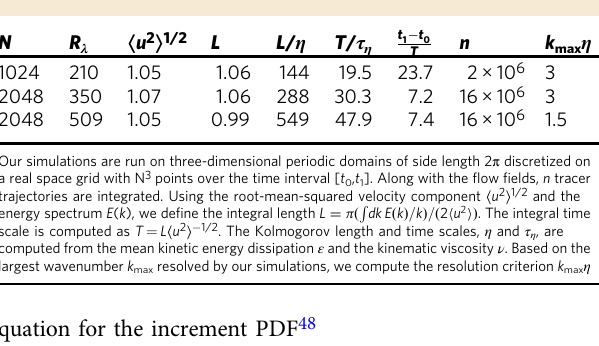
Table 1 Main DNS